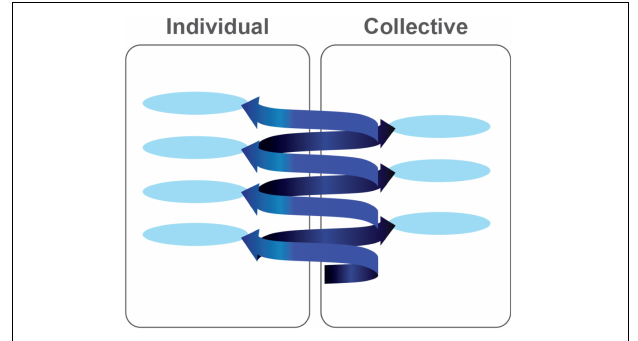
FIGURE 1 | Transformative learning